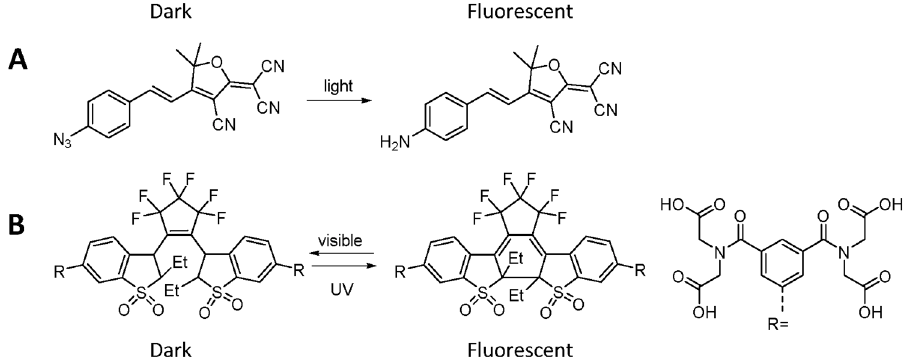
Figure 17. Fluorophores for stochastic fluorescent imaging. ( A ) Photoactivable fluorophore by photoreduction; ( B ) Photoswitchable diarylethene fluorophore.